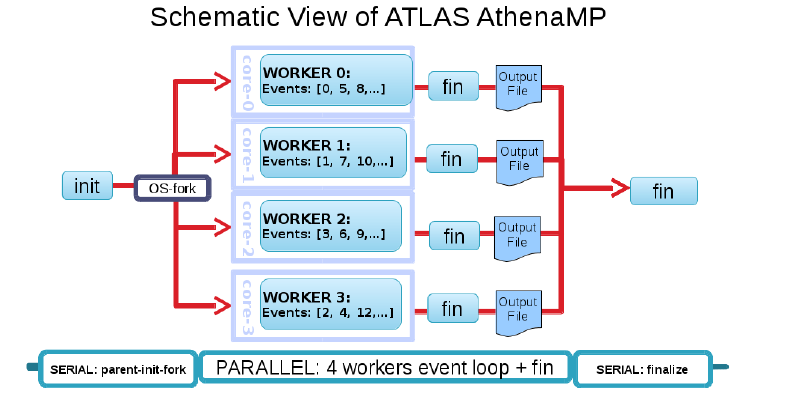
Figure 4: Schematic view of AthenaMP, based on Linux copy-on-write sharing mechanism